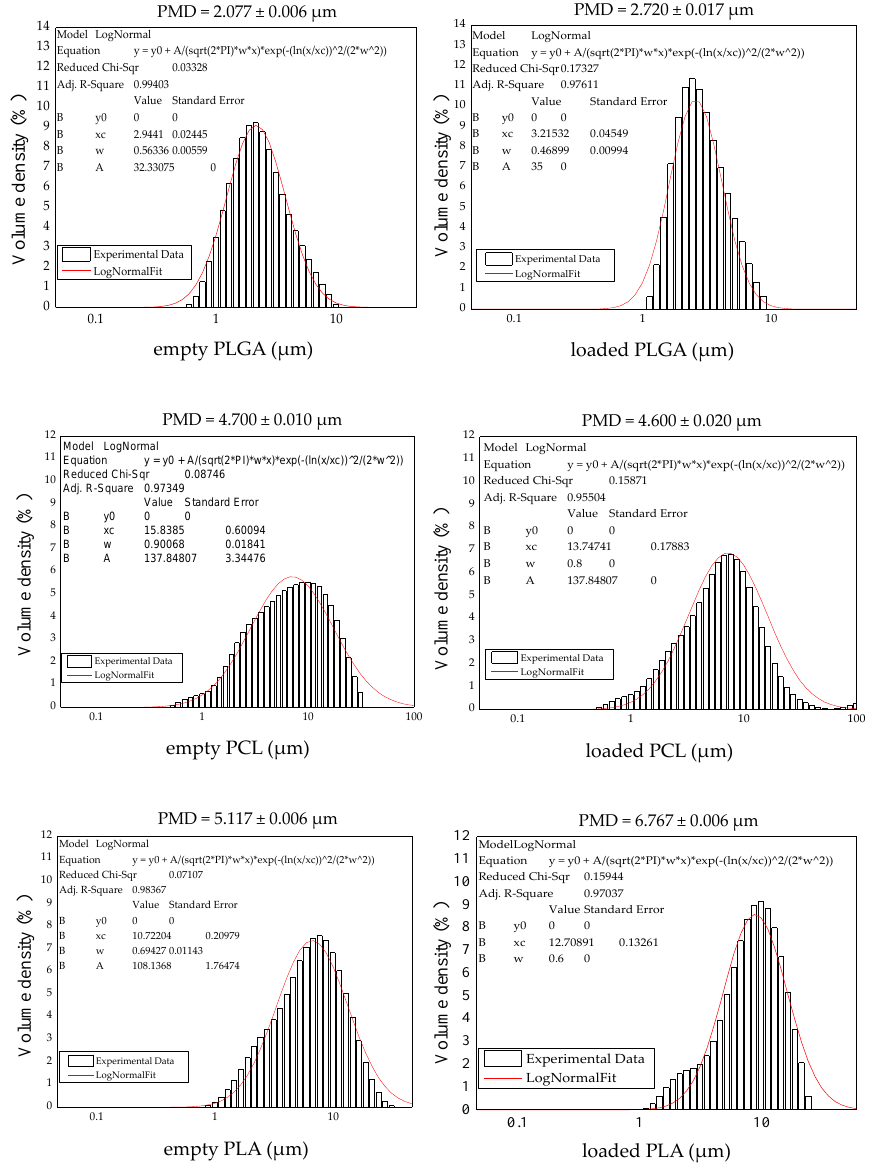
Figure 3. PMD and diameter distribution of MPs produced with the different polymers. PMD: particle mean diameter, PLGA: poly(lactic- co -glycolic acid), PCL: poly( ε -caprolactone), PLA: poly(lactic acid) both loaded and empty.